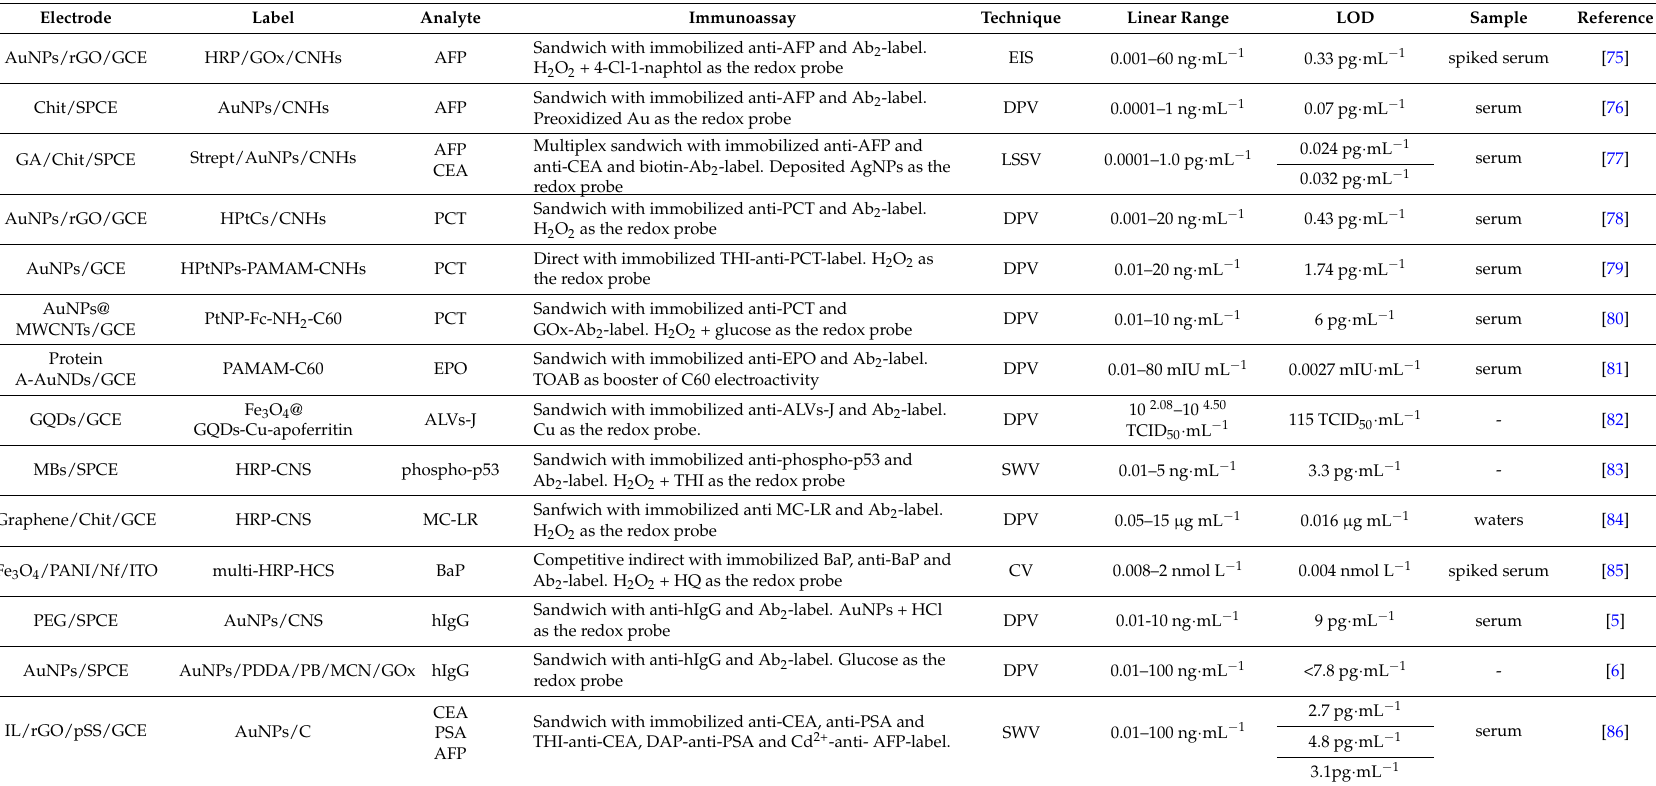
Table 3. Electrochemical immunosensors using uncommon carbon nanostructures as